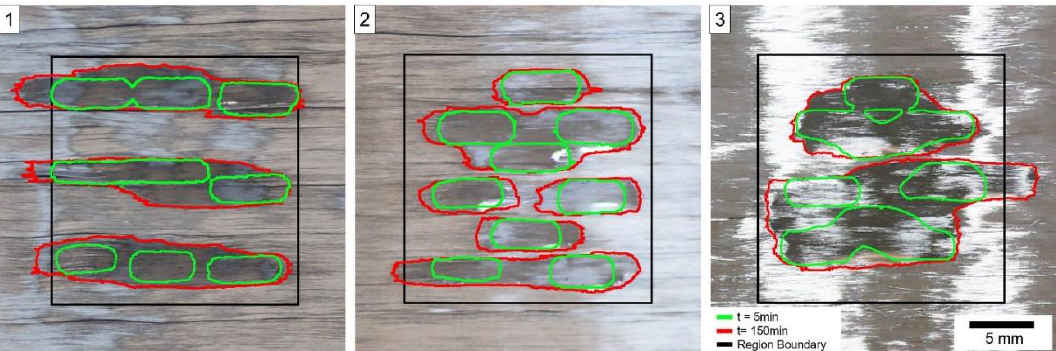
Figure 12. Images showing the extent of fluid coverage for all three grids, including 5 min and 150 min after deposition.